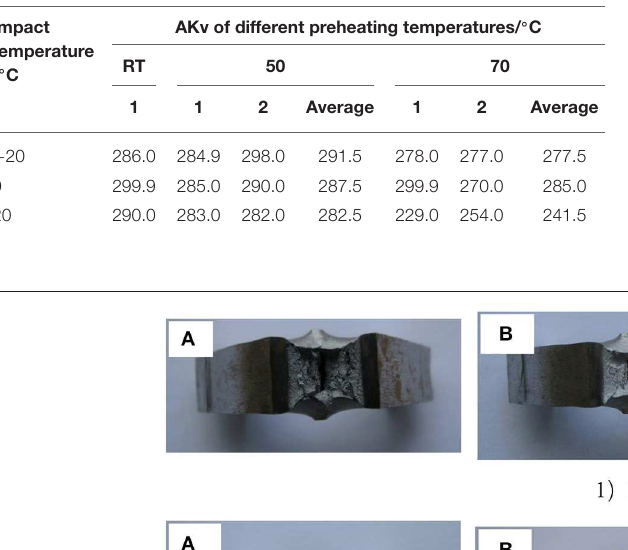
TABLE 5 | Results of Charpy V-notch of the HAZ/J.